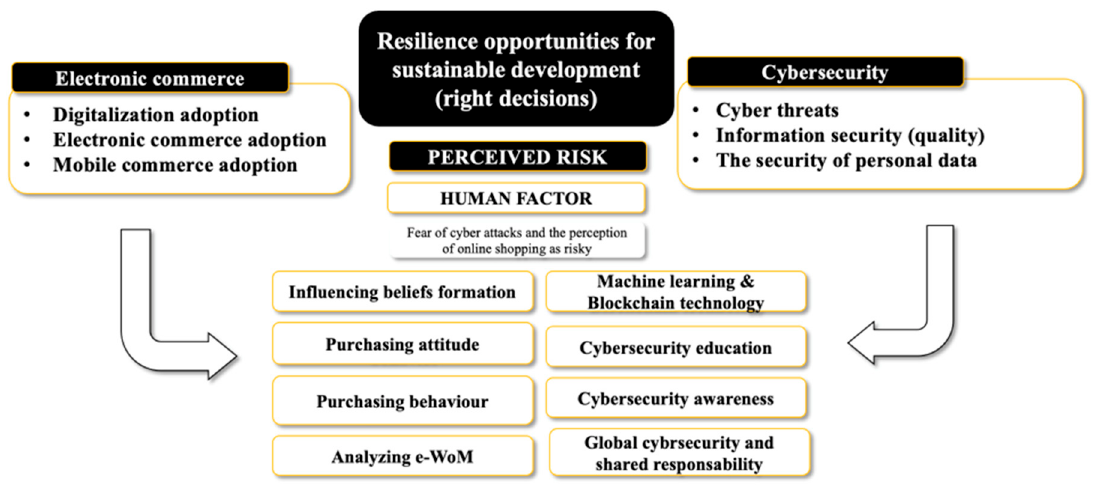
Figure 8. The Resilience Right Decisions for Electronic Commerce and Cybersecurity Model.